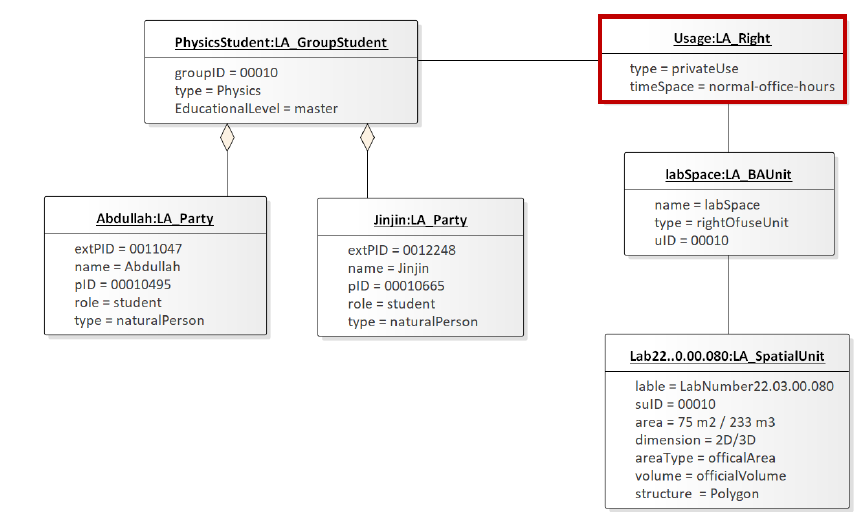
Figure 3. The administrative package of